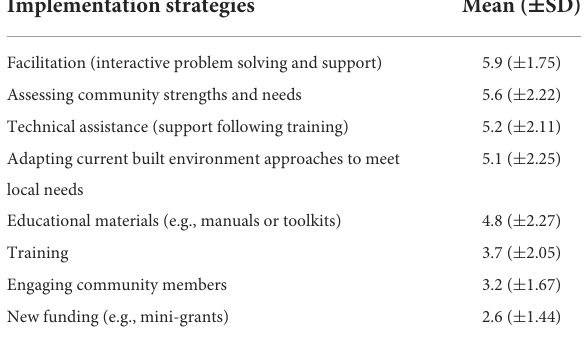
TABLE 2 Ranked order of desired implementation strategies.